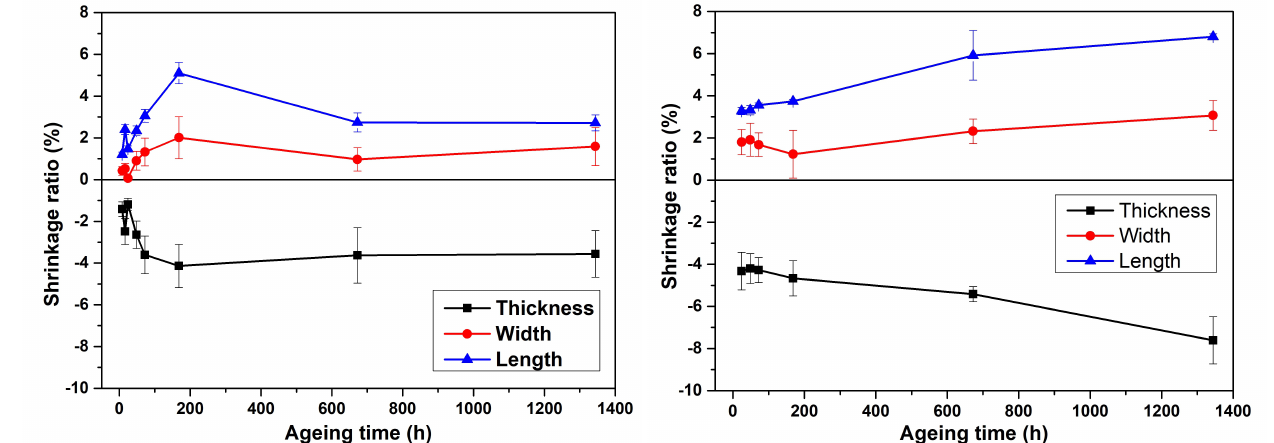
Figure 1. Shrinkage ratios in width, length, and thickness directions versus aging time for thermal aging ( left ) and hydrothermal aging ( right ). Error bars are inserted considering standard deviations for six calculated shrinkage